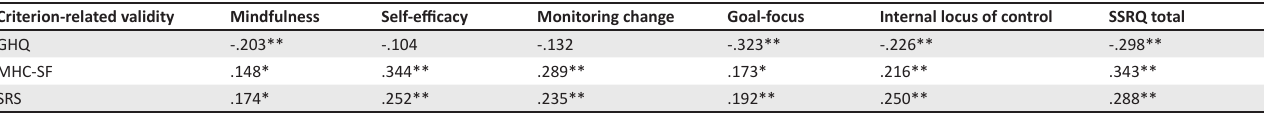
TABLE 4: Criterion-related validity: Pearson correlation coefficients of the SSRQ components with other measures of psychological well-being (GHQ and MHC-SF) and self-regulation (SRS). Criterion-related